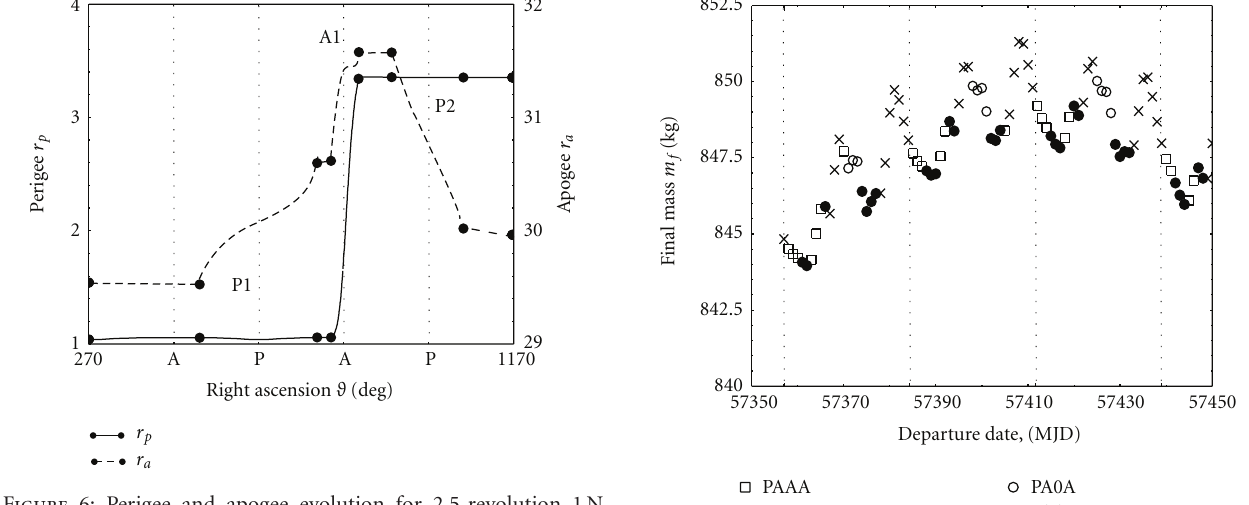
Figure 6: Perigee and apogee evolution for 2.5-revolution 1N transfer (J2 only).